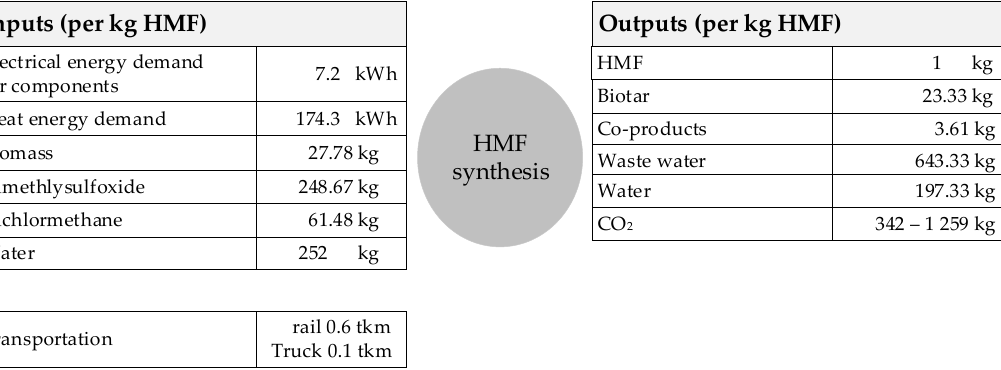
Figure 2. Material and energy flows as well as CO 2 emissions during HMF synthesis (according to the pilot process of the authors of [15]).